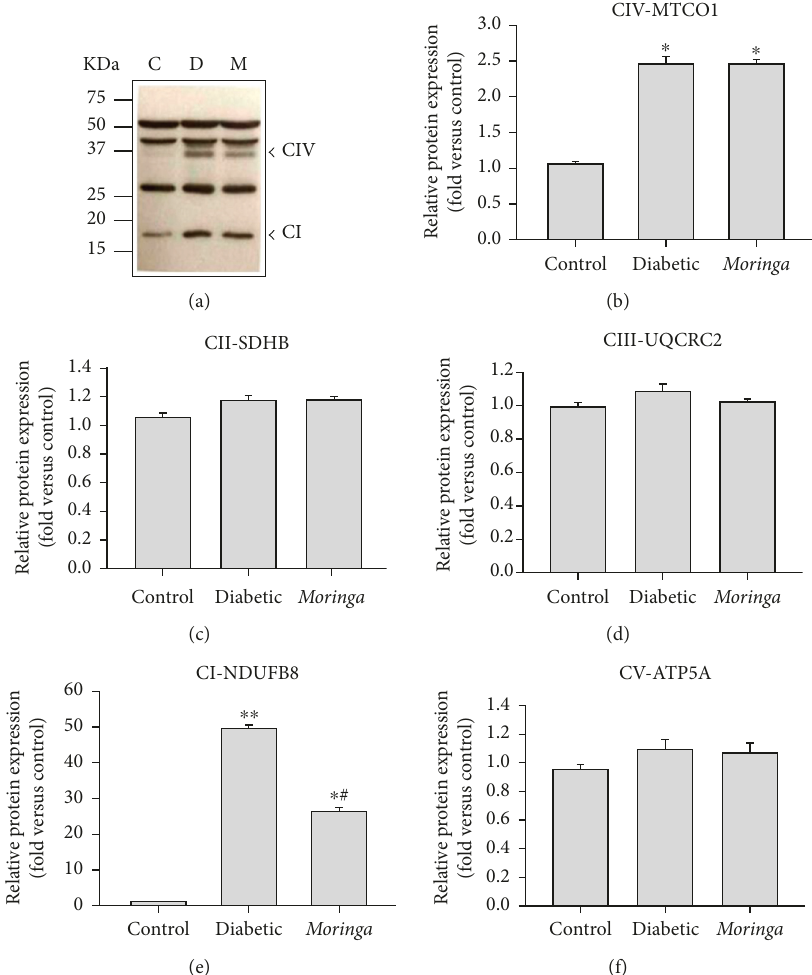
Figure 2: Characterization of OXPHOS proteins expressed in liver mitochondria during diabetes. (a) OXPHOS cocktail specificity demonstrated by a Western blot from liver-isolated mitochondria of diabetic rats and treated with Moringa extract. Relative expression of (b) MTC01 subunit of CIV, (c) SDHB subunit of CII, (d) UQCRC2 subunit of CIII, (e) NDUFB8 subunit of CI, and (f) ATP5A subunit of CV was performed by densitometric analysis from gel. Molecular mass standards are shown on the left panel of the gel. C: control; D: diabetic; M: Moringa -treated group. Data are shown as mean band density normalized relative to UQCR2. Significant differences are represented